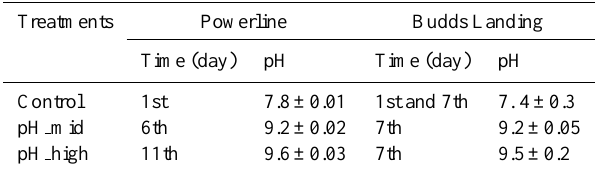
Table 2. Experimental overlying water pHs for experimental incu- bation of cores from the Powerline and Budds Landing sites. The Powerline incubations had a sequential change of pH ( n = 4). The Budds Landing incubation had all cores ( n = 9) at neutral pH on the first day, and then set 3 replicate cores at 3 different pHs, re- spectively. pH data are the mean